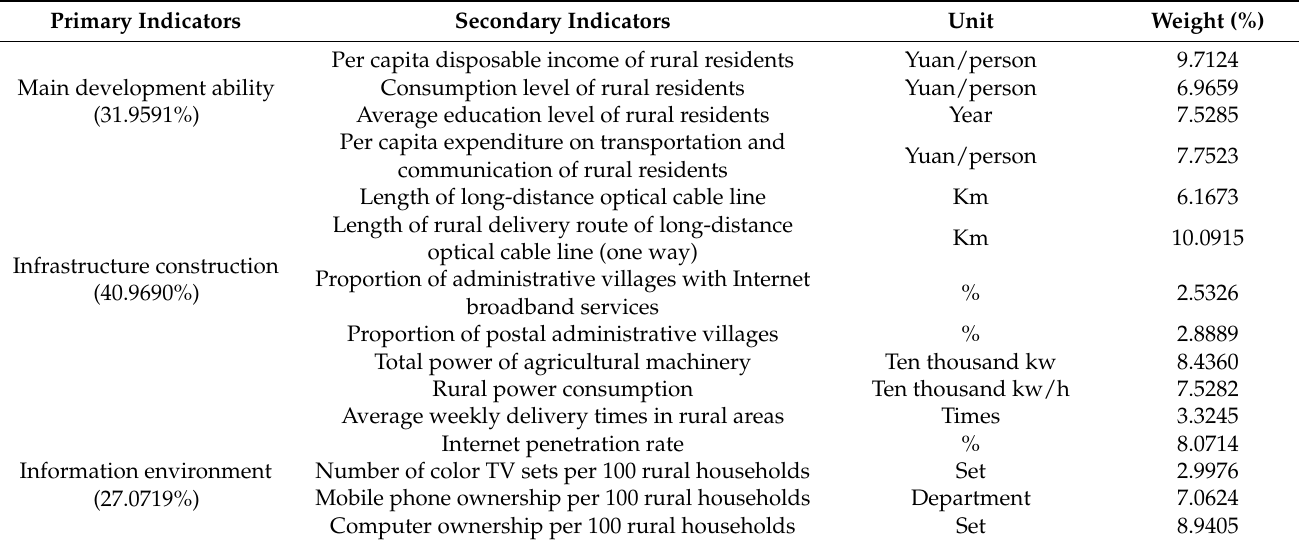
Table 1. The evaluation index system of